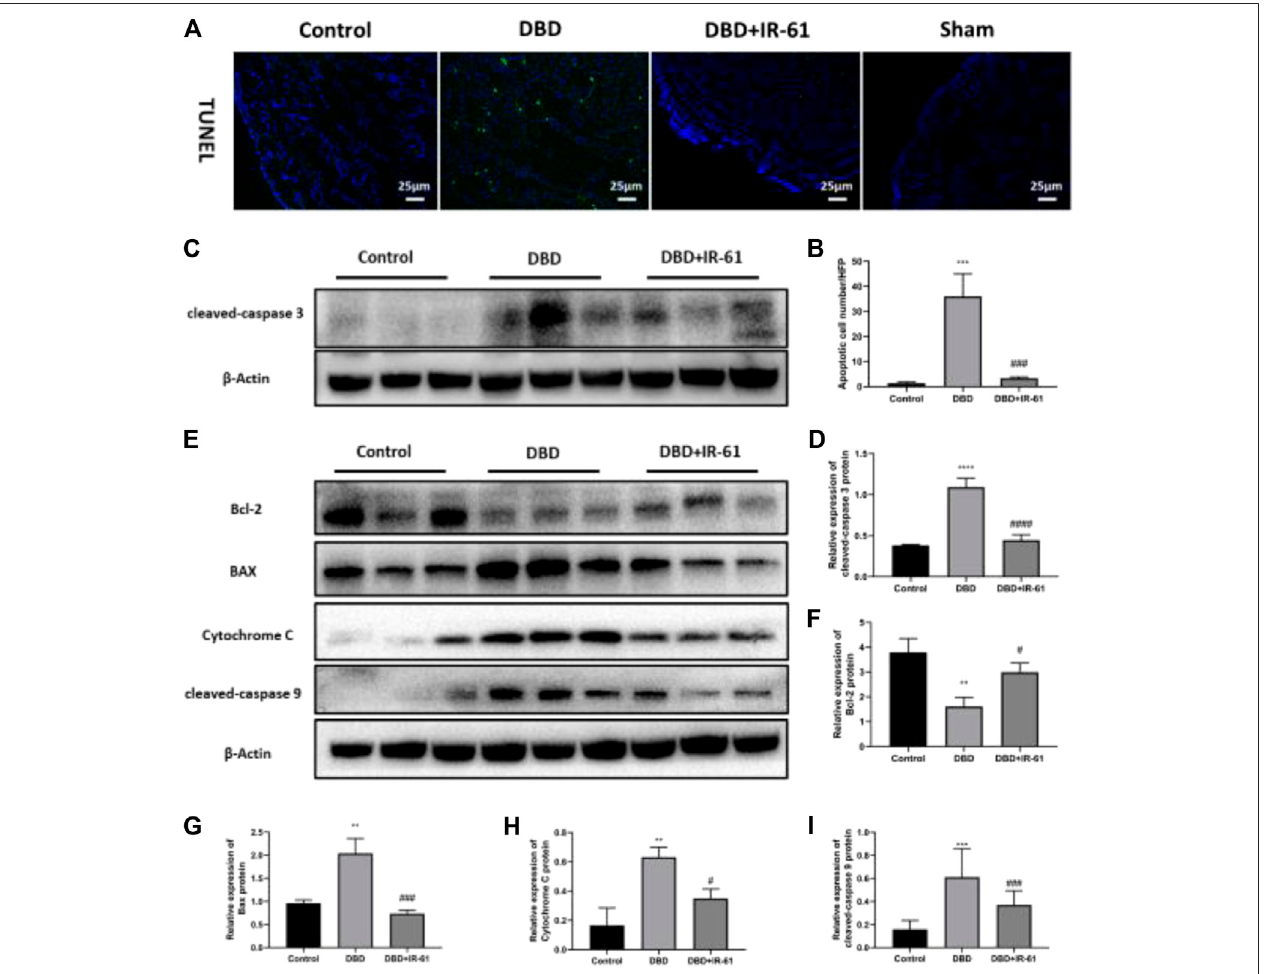
FIGURE 4 | IR-61 reduced number of apoptotic BSMCs in DM and affected mitochondrial apoptosis-related proteins. (A) Representative images of TUNEL staining(green)inbladder. (B) NumberofapoptoticBSMCsperhigh-power fi eld. (C,D) Levelsofcleaved-CaspasethreeinbladdersdetectedbyWesternblot. (E – I) Bcl- 2, BAX, Cytochrome C, and cleaved-caspase nine expression levels in each group and quantitative analysis. Data indicate the mean ± SD (* p < 0.05, ** p < 0.01, *** p < 0.001 vs. control group; # p < 0.05, ### p < 0.001 vs. DBD